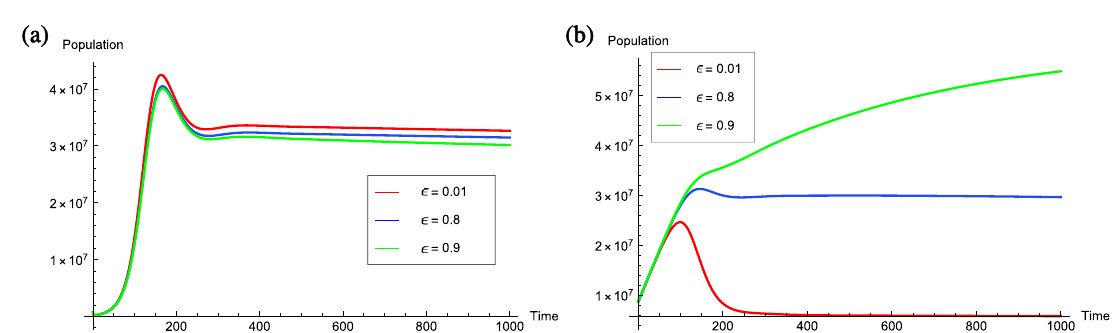
Figure 7. Graphs illustrating the influence of the efficacy of vaccination among individuals. The graphs are plotted by varying the value of ε from 0.01 to 0.9 for; ( a ) Total infectives ( b ) Vaccinated